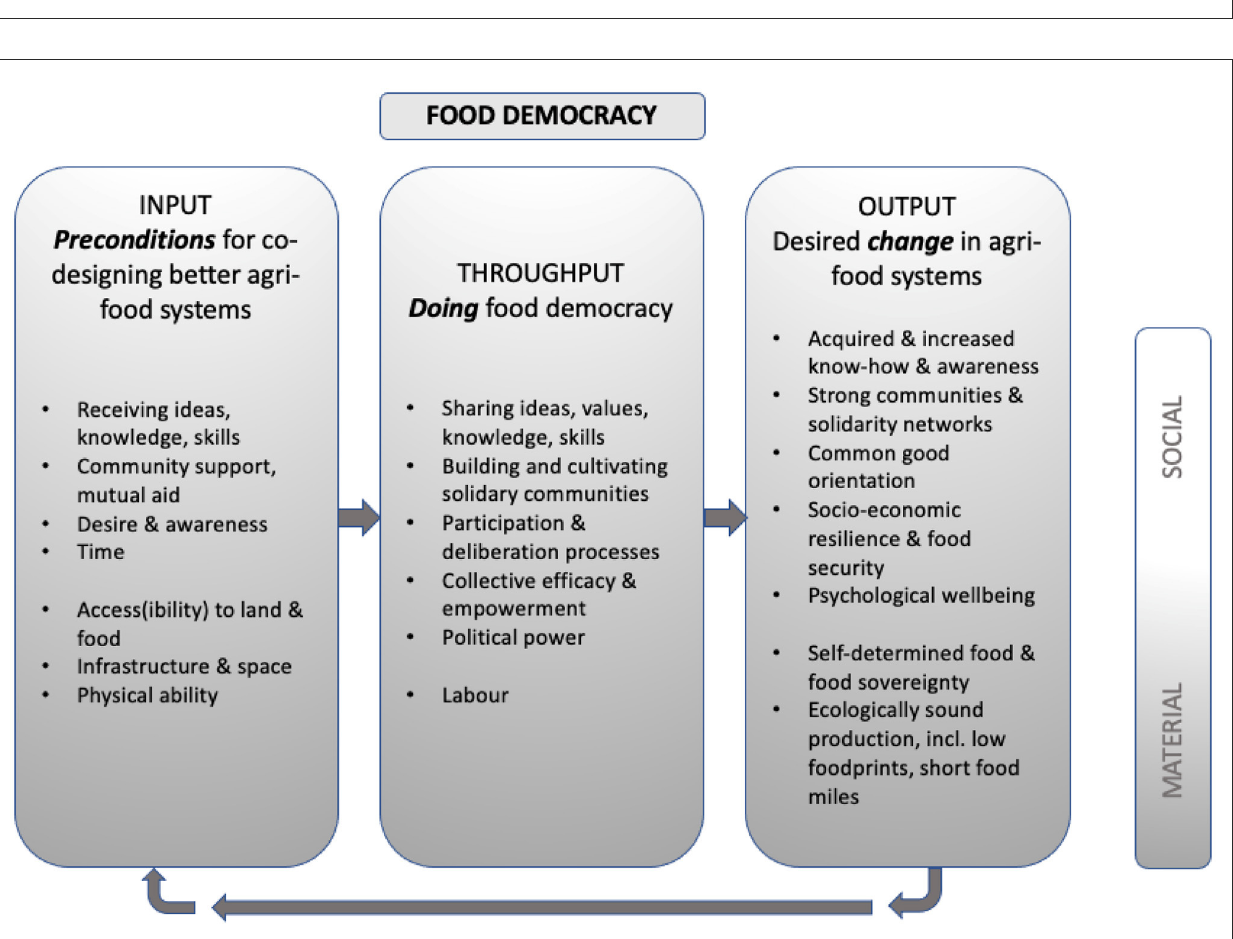
FIGURE2 Empirical framework as inspired by the work of Hassanein (2008) and Bornemann (2022), as well as by theories of participatory (Pateman, 2000, 2012), deep (McIvor and Hale, 2015), and strong democracy (Barber, 2004), and our empirical data.